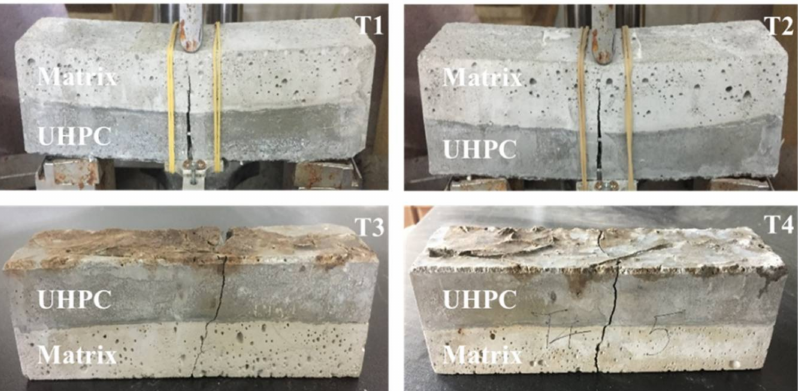
Figure 6. Failure modes of the UHPC repaired systems under different temperatures (Sf1pp1